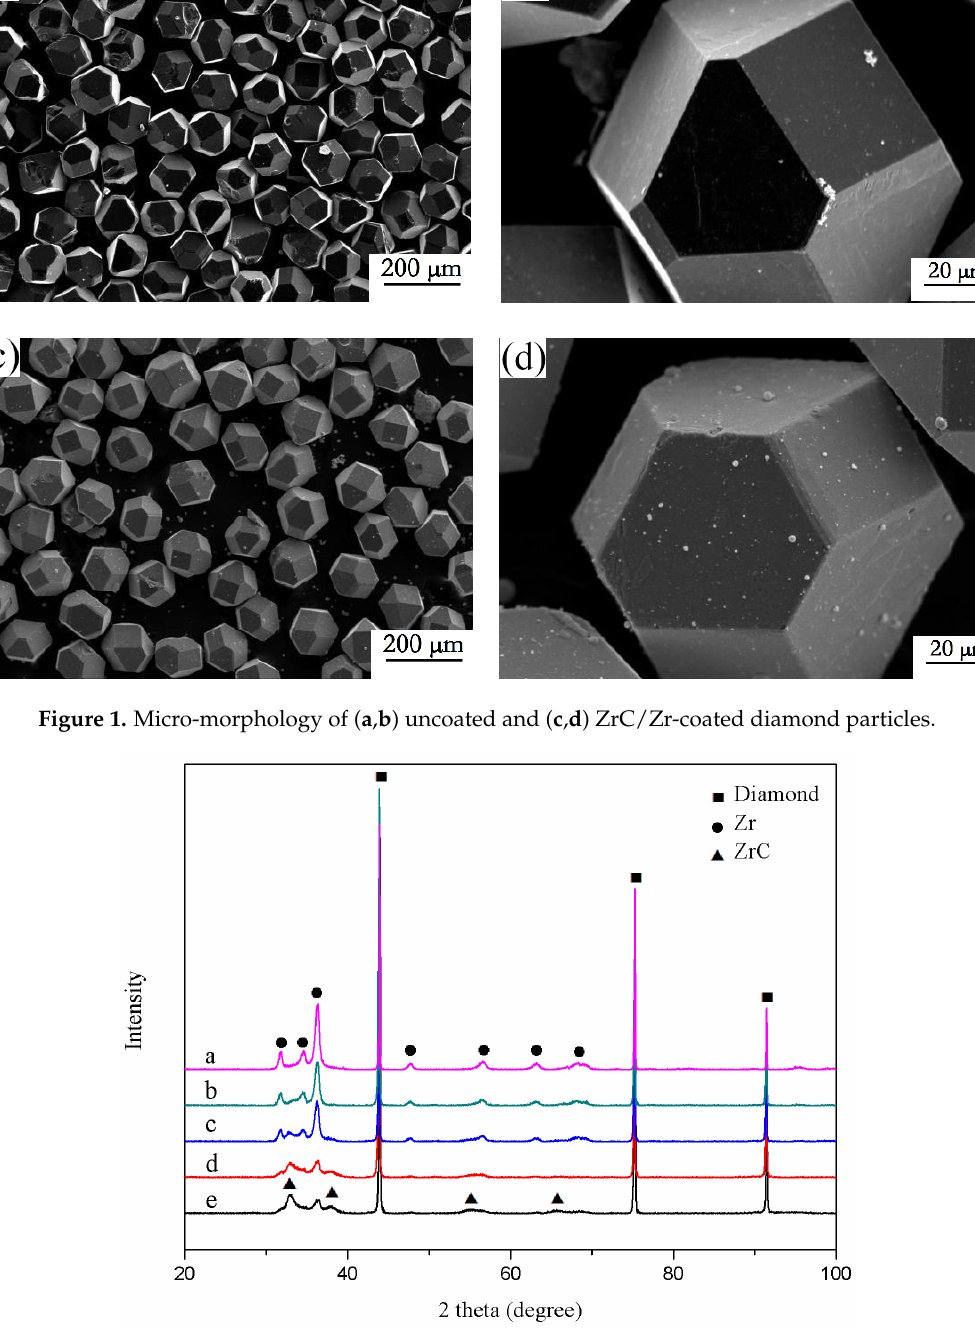
Figure 2. XRD of ZrC/Zr-coated diamond with different heat treatment time: ( a ) 0 min; ( b ) 5 min; ( c ) 10 min; ( d ) 20 min and ( e ) 30